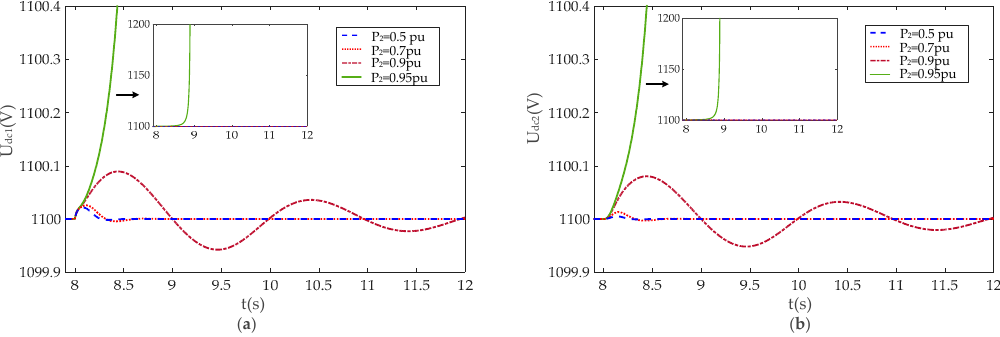
Figure 15. DC ‐ link voltage responses under different VSC2’s PLL bandwidths in ( a ) VSC1, ( b ) VSC2. Figure 15. DC-link voltage responses under di ff erent VSC2’s PLL bandwidths in ( a ) VSC1, ( b ) VSC2.